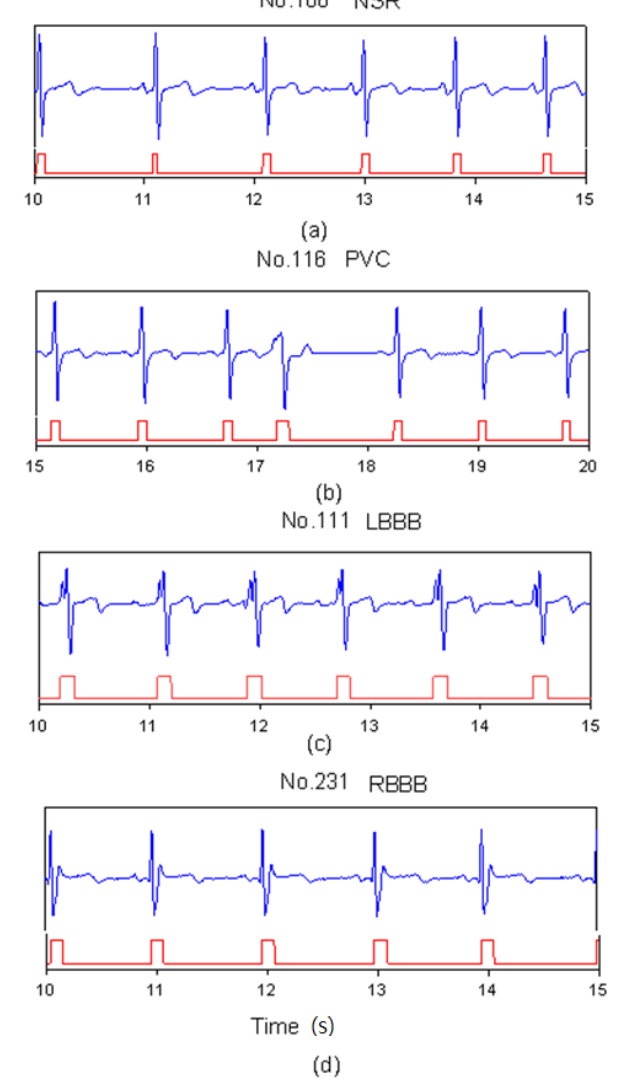
Figure 3. SVM marks the heartbeats of ECG, ( a ) NSR beats for file No. 106, ( b ) PVC beats for file No. 116, ( c ) LBBB beats for file No. 111, and ( d ) RBBB beats for file No.